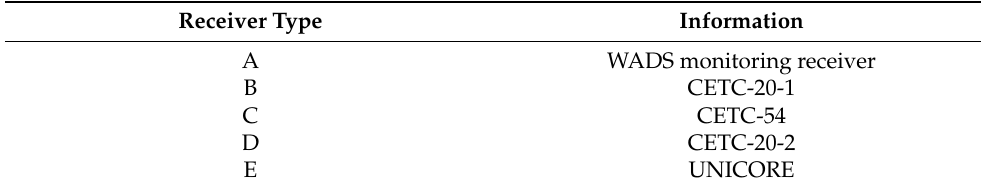
Table 3. Information about the five receiver types.